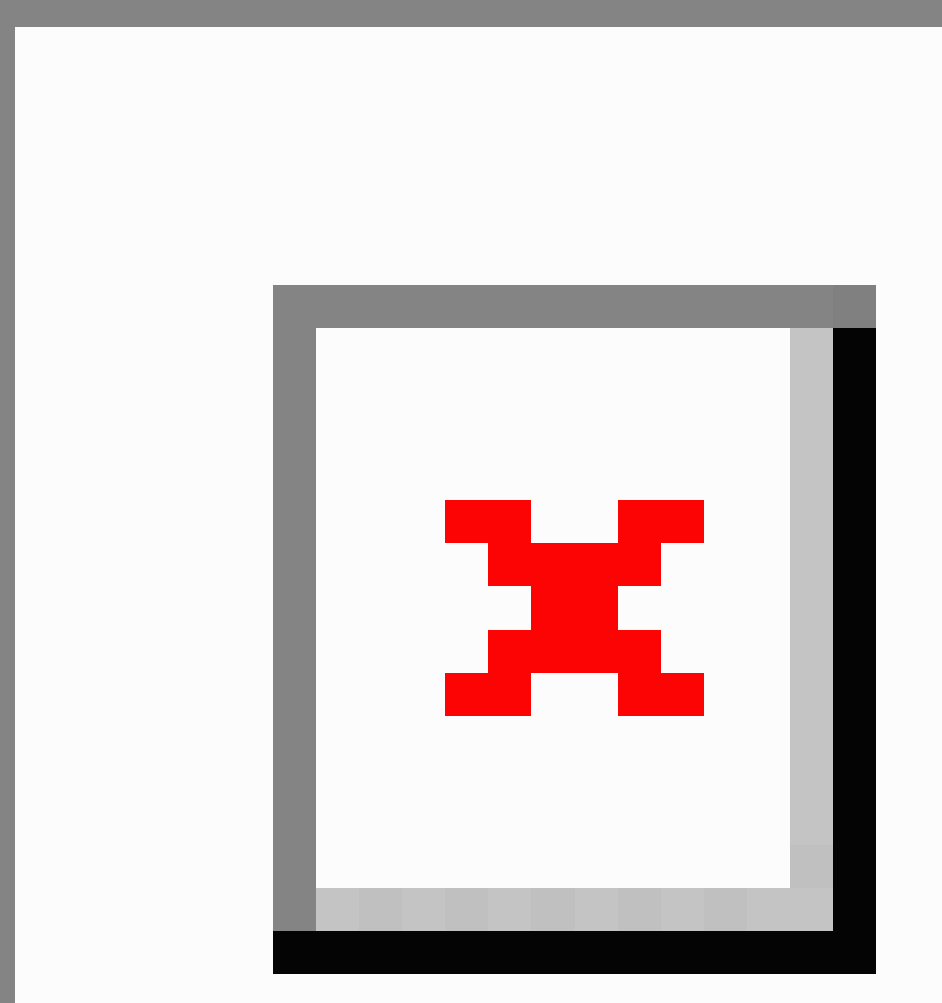
Figure 2. How WordPress automatically converts an online portal into a Web-based